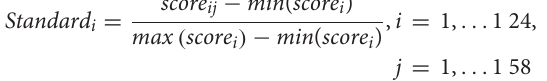
FIGURE 1 | Result of SAS vs. HAMA and SDS vs. HAMD.